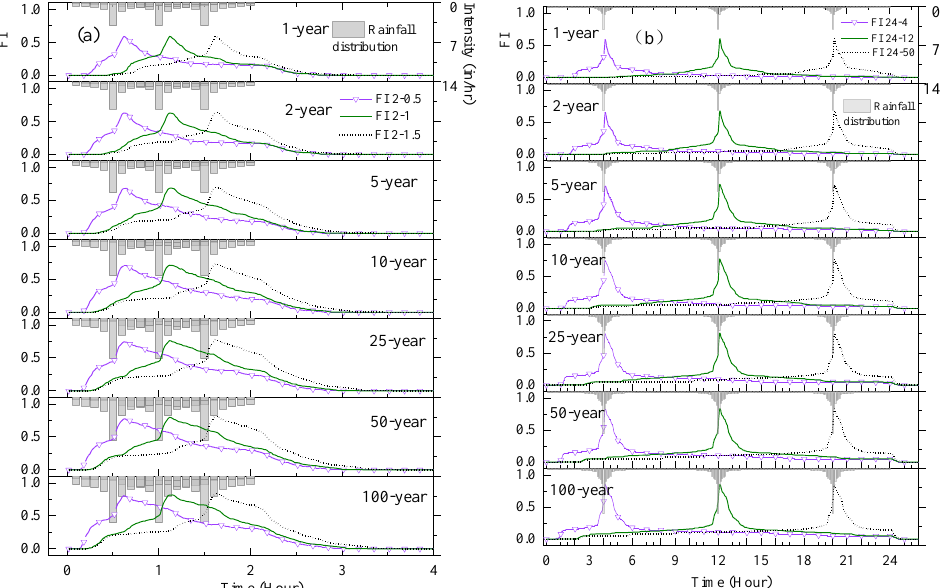
Figure 6. The variations in the fraction of road inundation in different rainfall patterns. ( a ) 2-h event, ( b ) 24-h event. The grey histogram shows the rainfall distribution, the purple curve with triangles indicates 2-0.5 and 24-4 events, the green lines indicate 2-1 and 24-12 events, and the dotted lines indicate 2-1.5 and 24-20 events.